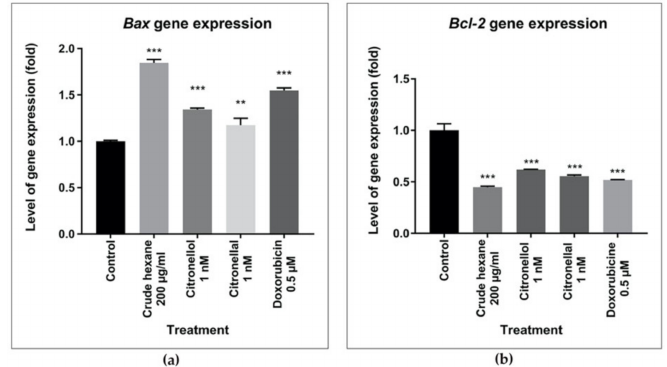
Figure 7. Alteration apoptosis-related genes expression ( a ) Bax and ( b ) Bcl-2 . Data are presented as means ± SEM. One-way ANOVA was used to analyze the di ff erence between control group and treatment groups. p value < 0.05 considered significant (** p < 0.01, *** p <